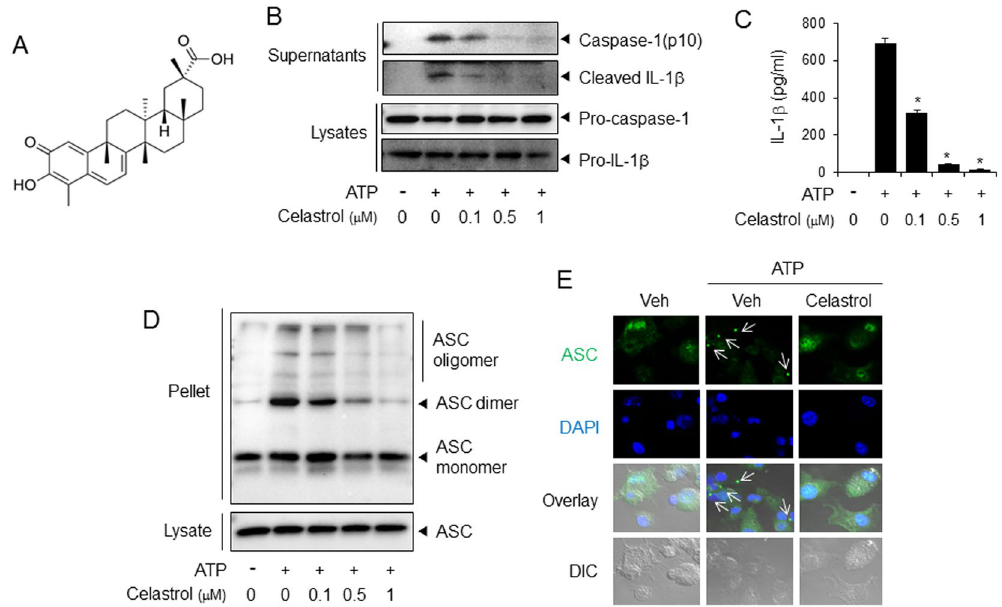
Figure 5. Celastrol inhibits ATP-induced activation of NLRP3 inflammasome in primary macrophages. ( A ) Chemical structure of celastrol. ( B – E ) Primary mouse macrophages were primed with LPS (100 ng/ml) for 4 hr. The cells were treated with celastrol for 1 hr and then stimulated with ATP (5 mM) for ( B , D , E ) 1 hr or ( C ) 2 hr. ( B ) The cell culture supernatants and cell lysates were immunoblotted for pro-caspase-1, caspase-1(p10), pro- IL-1 β , and IL-1 β . ( C ) The cell culture supernatants were analyzed for secreted IL-1 β using ELISA. The values represent the means ± SEM (n = 3). * Significantly different from ATP alone, p < 0.05. ( D ) Cell lysates were processed for immunoblotting of ASC. ( E ) The cells were stained for ASC (green). The nuclei were stained with 4 ′ ,6-diamidino-2-phenylindole (DAPI; blue). The arrows indicate ASC speckles. The data are representative of three independent experiments. For immunoblotting results, the cropped blots from full length gels were presented. DIC, differential interference